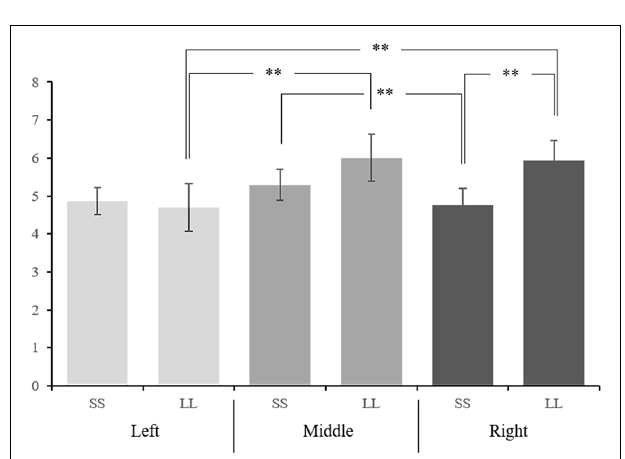
FIGURE 3 | The interaction effect between option and hemisphere of mean amplitudes of P3a at nine electrodes. ∗∗ p < 0.05.